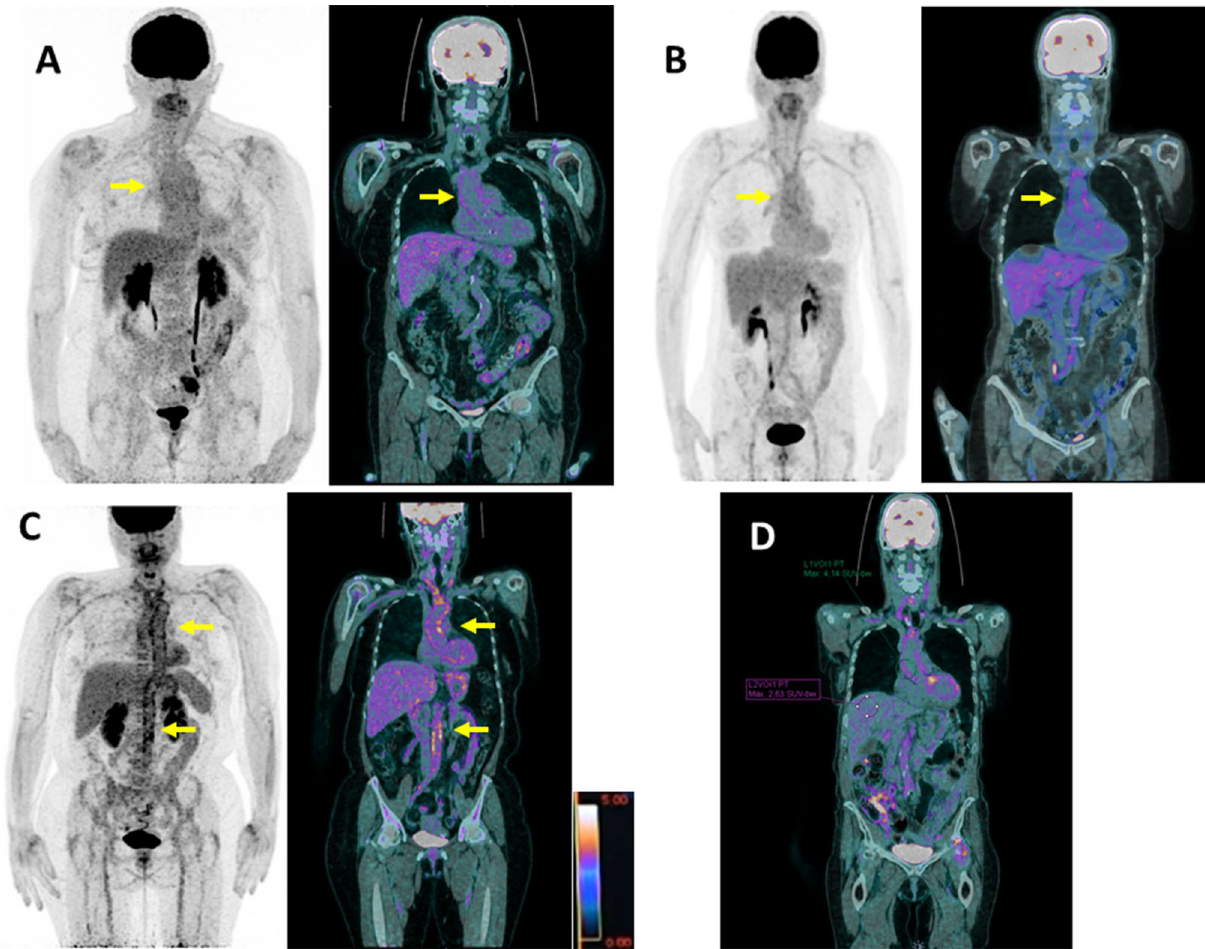
Figure 2. ( A ) FDG-PET/CT showing grade 1 uptake of the thoracic aortic wall (< liver uptake but > mediastinum background) in maximum intensity projection (MIP) image (left) and coronal fused (PET with CT) slice (right). SUV max value of the thoracic aortic wall: 2.9; ( B ) FDG-PET/CT showing grade 2 (equal to liver background) large vessel vasculitis uptake (including the thoracic aorta) in maximum intensity projection (MIP) image (left) and coronal fused (PET with CT) slice (right). SUV max value of the thoracic aortic wall: 4.2; ( C ) FDG-PET/CT showing grade 3 (> liver uptake) large vessel vasculitis uptake (including the thoracic and abdominal aorta) in maximum intensity projection (MIP) image (left) and coronal fused (PET with CT) slice (right). SUV max value of the thoracic aortic wall: 6.9; ( D ) FDG-PET/CT coronal fused (PET with CT) slice illustrating the target-to-liver background ratio (TBR max liver) in a patient with large vessel vasculitis. SUV max value of the target (ascending thoracic aortic wall) is recorded with a region of interest (ROI) drawn manually around the target arterial structure. SUV max value of the liver background is estimated with a ROI projected on the healthy right lobe to reduce the risk of including the various veins and arteries running through the liver. TBR max liver of the ascending thoracic aorta: 4.14/2.63 = (≤ mediastinum); grade 1, vascular wall uptake < liver uptake; grade 2, vascular wall uptake equal to liver uptake; grade 3, vascular wall uptake greater than liver uptake (Fig. 2) 7,8 . Aortic images were segmented according to 5 anatomical regions: ascending thoracic aorta, aortic arch, descending thoracic aorta, abdominal suprarenal and infrarenal aorta. Total vascular (TVS) 9 and PETVAS scores 10 were performed (Fig. 3). An aortic score was calculated corresponding to the sum of the visual grading of the 5 aortic segments. An analysis of the different aortic segments was performed by placing Regions of Interest (ROIs) around the vessel in cross section. The selected segments were defined according to the Most Diseased Segment (MDS) 11 , meaning that the slice with the highest SUV max is selected and then the mean of the SUV max from this and the two neighboring slices is calculated (Fig. 3). Different target to background ratios (TBRs) were also recorded by measuring the maximal standardized uptake value (SUV max ) of each reference organ. Ratios between aortic wall SUV max and reference site SUV max were evaluated by placing ROIs of similar size (4 cm 3 ): – Target-to-liver ratio (TBR max liver) by placing a ROI on the right lobe of the liver (Fig. 2);